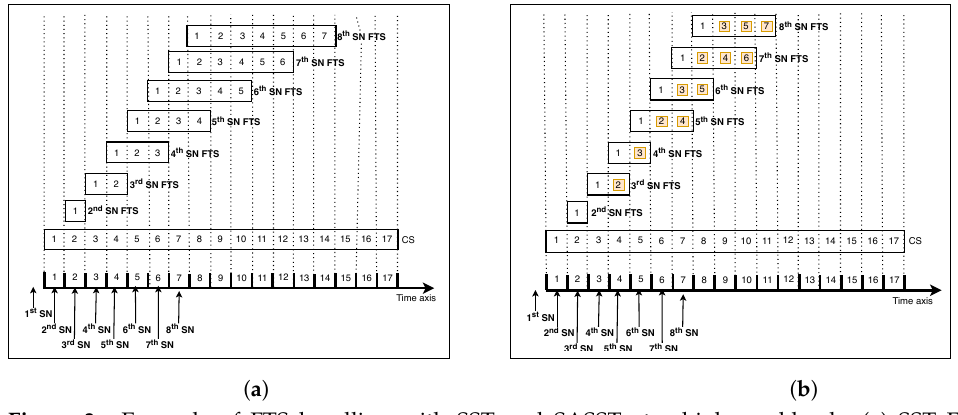
Figure 3. Example of FTS handling with SST and SASST at a high workload. ( a ) SST FTS; ( b ) SASST